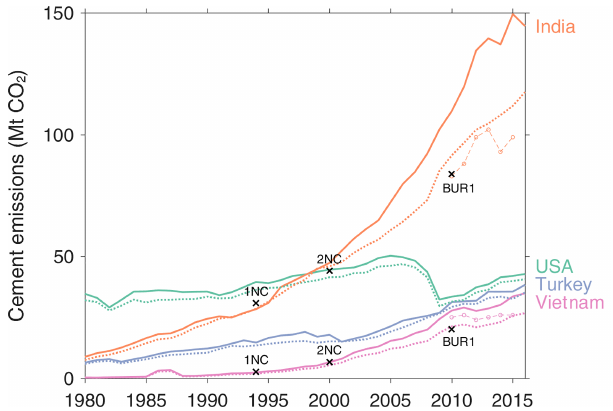
Figure 4. Comparing new cement emissions estimates (dashed lines) for the top four cement producers after China with those from CDIAC (solid lines) and official estimates (crosses, India and Viet- nam) as reported to the UNFCCC (see text). The new estimates for the USA and Turkey come directly from national official estimates. Estimates from EDGAR v4.3.2_FT2015 are shown for India and Vietnam with round